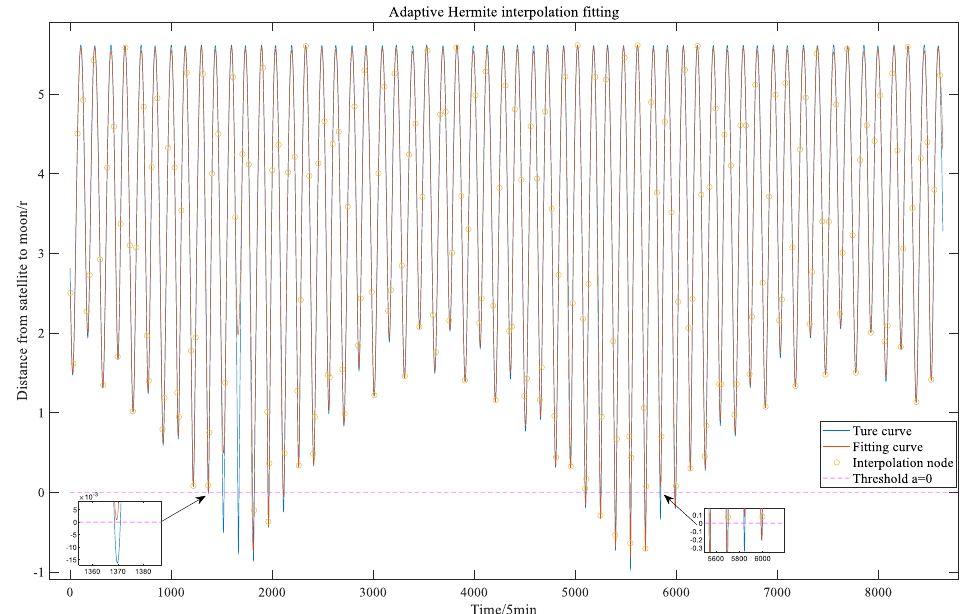
Figure 3. Conventional adaptive algorithm to fit the occlusion function. To avoid this problem, in this paper, the basic idea is to try to make the local extremal points of the multi-hump function the endpoints of the subinterval, where the local extremal points are the “vertices”. This method not only avoids the visibility calculation error, but original function within that subinterval without constructing a cubic polynomial in each subinterval. The interpolation method must know the original function values of the